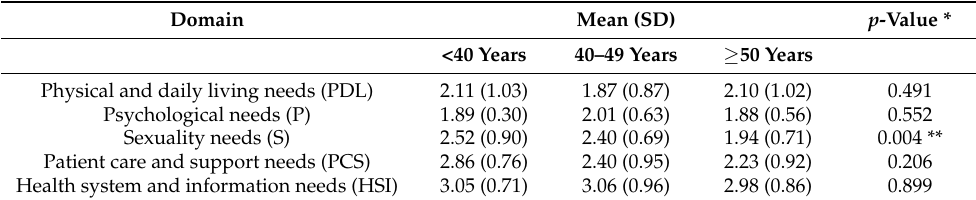
Table 5. Comparison of age group with SCNS-SF34 Malay domains